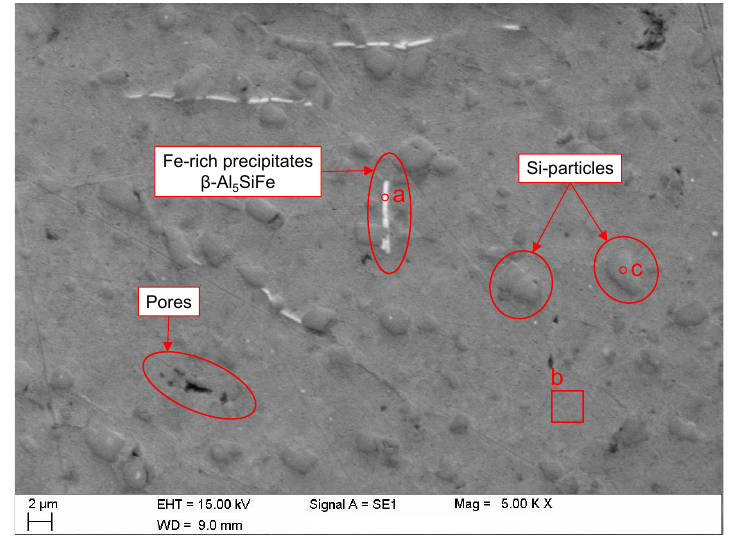
Figure 5. Microstructure in post treated condition including EDX